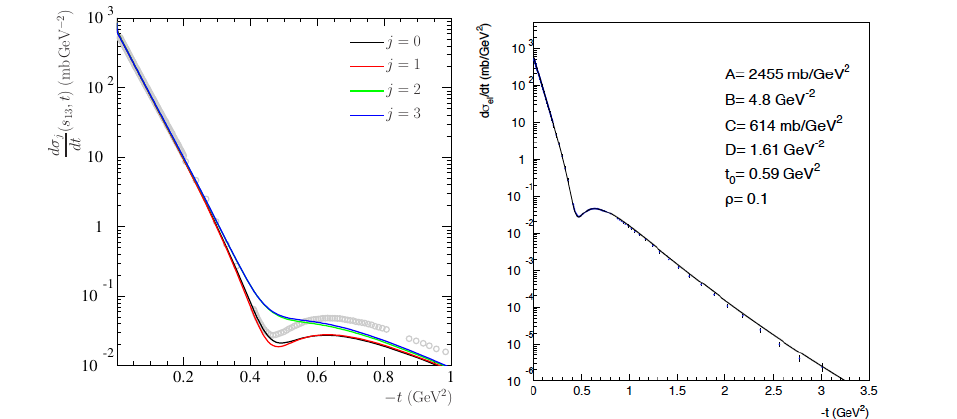
Figure 4. Left panel: application to the 13 TeV TOTEM data, read from [13], of the asymptotic empirical model described in the previous subsection, in the original and in the rotated version using model mBP2 from [11], and t 0 = 0 . 71 GeV 2 . In the right panel, we show a free parameter fit of pp data using the mBP2-1 model with the Form Factor multiplying both terms in the amplitude. The expression used for the free fit includes the Coulomb term, but no additional phase between the Coulomb and the nuclear amplitude. The χ 2 / dof = 0 .